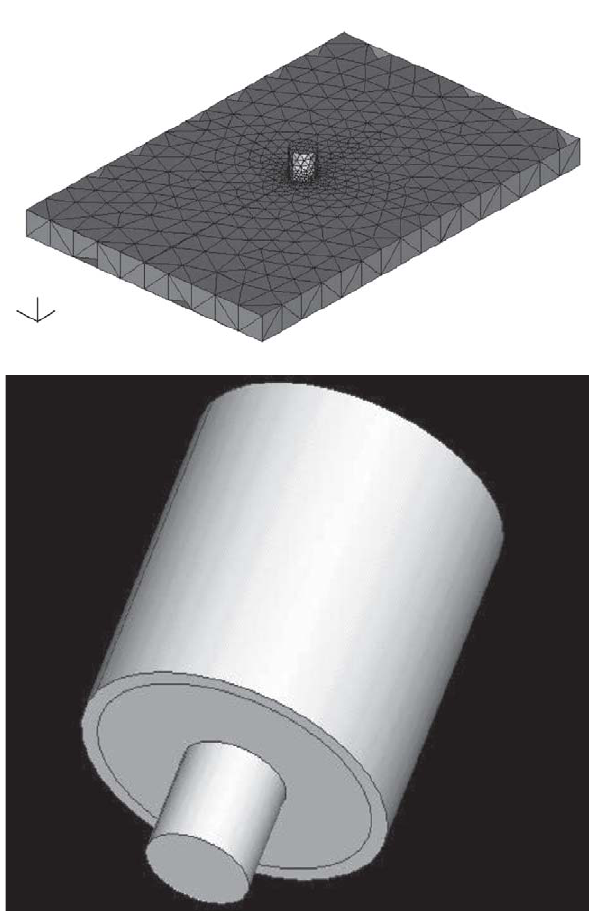
Figure 2. Tetrahedral finite element and tool sketch.